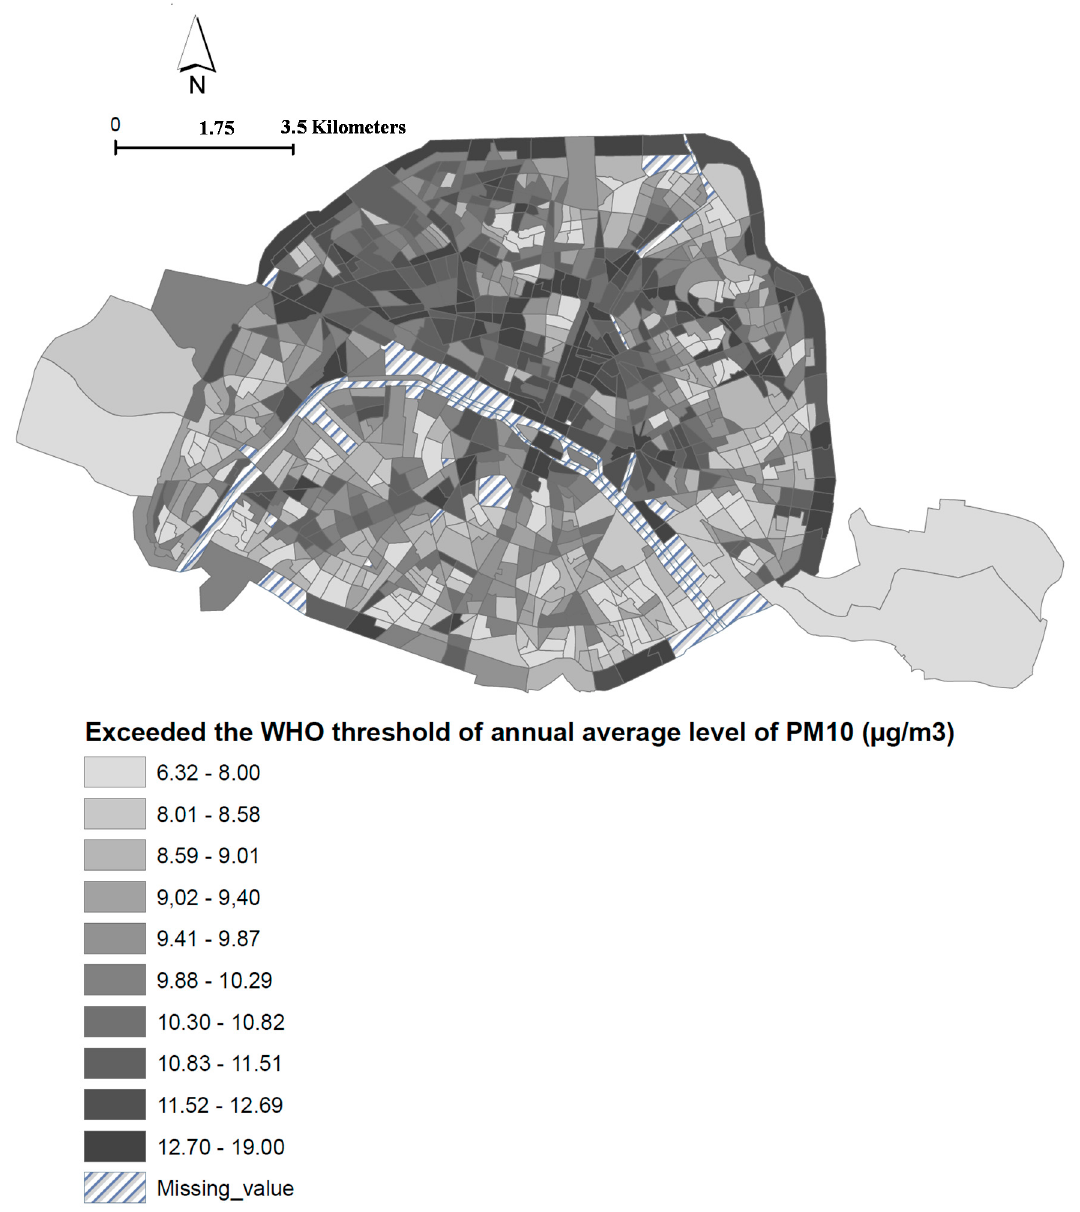
Figure A2. Spatial distribution of the exceeded the WHO threshold of annual average level of PM 10 from 2000–2009 (the difference between level of PM 10 exposure in each census block and WHO guidelines (20 μ g/m 3 )).